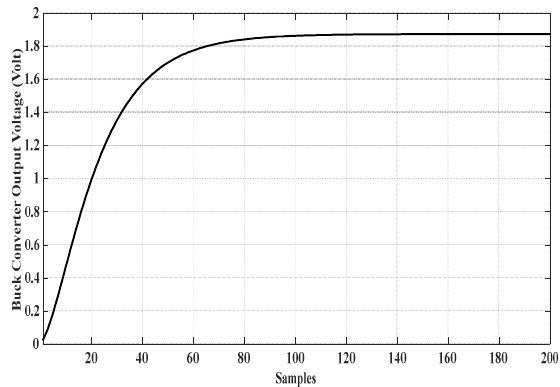
Fig. 5. Open loop response for output voltage of Buck converter